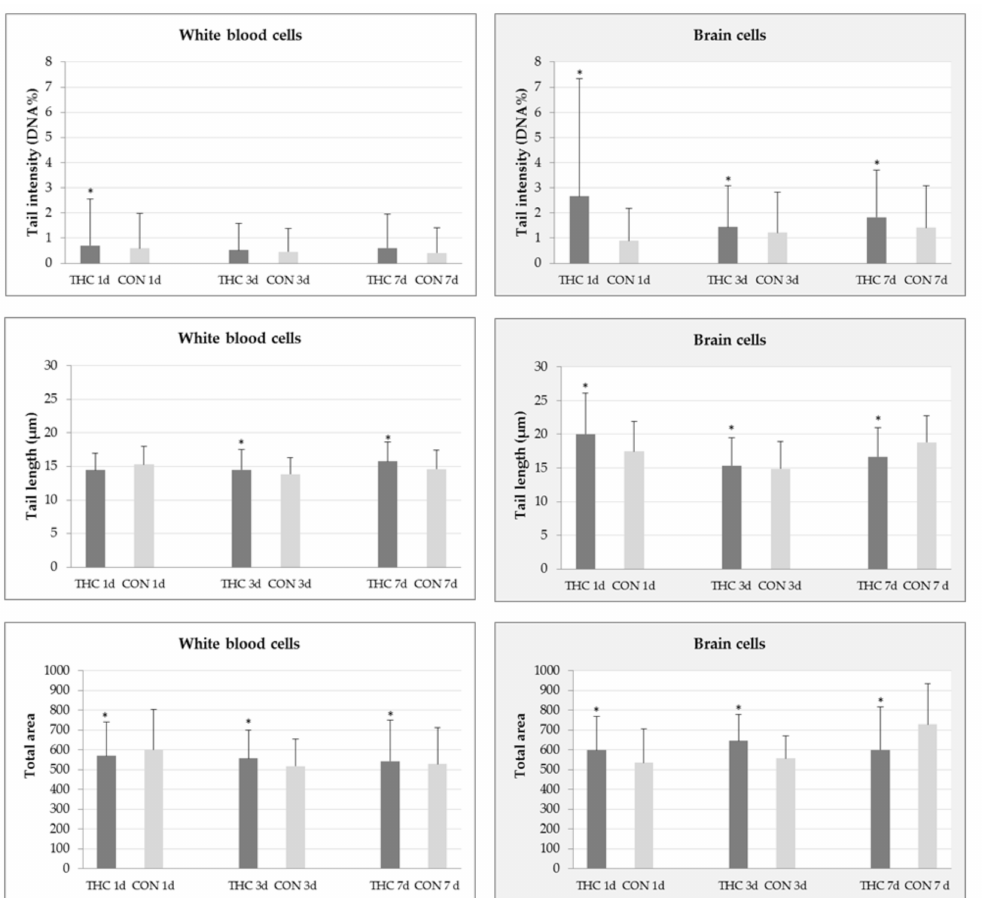
Figure 1. The levels of DNA damage measured using the alkaline comet assay in white blood cells and brain cells of male Wistar rats after 1-, 3-, and 7-day (d) treatments with ∆ 9 -tetrahydrocannabinol (THC) and in the respective controls. The daily THC dose was 7 mg / kg b.w.; it was dissolved in sesame oil and administered per os. Control rats (CON) received the same daily volume of sesame oil as the THC group. Data represent mean ± standard deviation. There were five rats per group, and 200 comets per rat were scored on duplicate slides (altogether one thousand independent comet measurements per each experimental group were made). * p < 0.05 vs. control (Mann–Whitney U